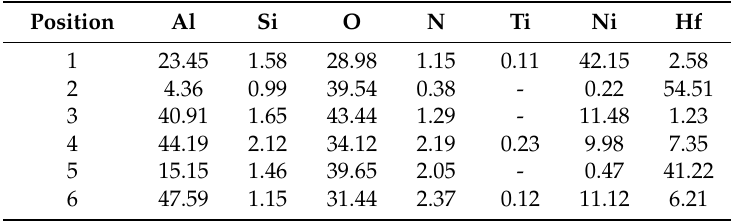
Figure 13. Macroscopical photos and cross-sectional SEM images of as-casted DZ22B alloy blades. ( a ) Blade photo (facecoat: fused alumina + 2 wt.% h-BN); ( b ) interfacial area image (facecoat: fused alumina + 2 wt.% h-BN); ( c ) blade photo (facecoat: fused alumina + 5 wt.% h-BN) and ( d ) interfacial area image (facecoat: fused alumina + 5 wt.% h-BN). Table 6. EDS analysis of the positions in Figure 12b,d (at.%).